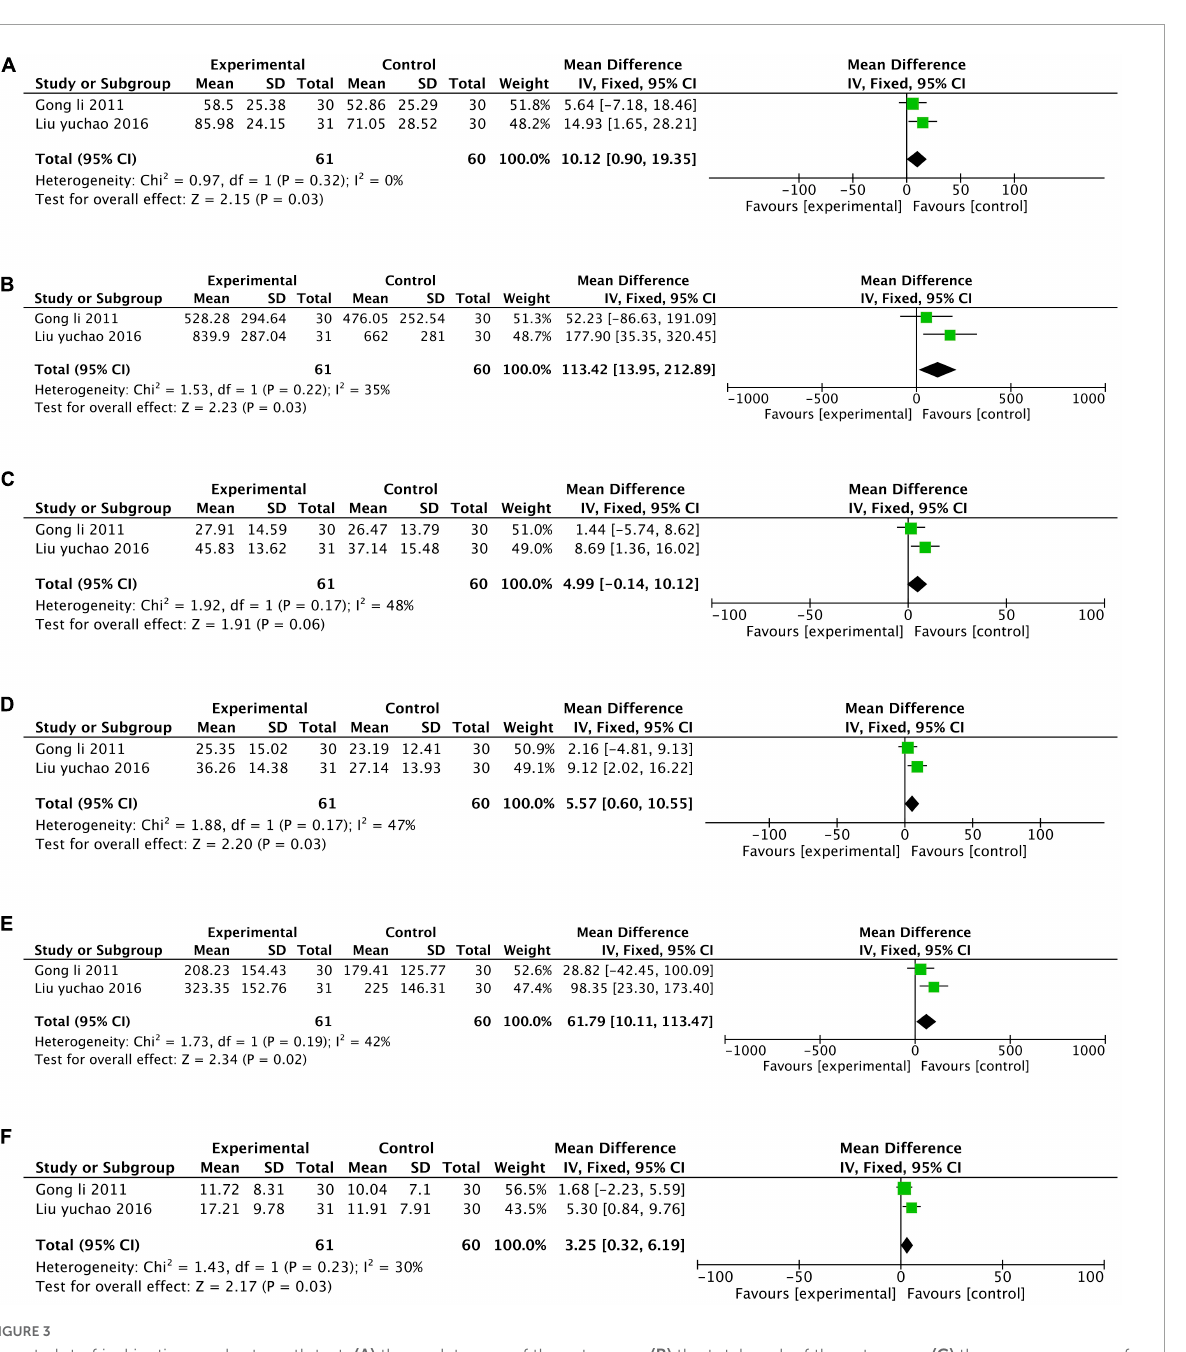
FIGURE3 Forest plot of isokinetic muscle strength test: (A) the peak torque of the extensors; (B) the total work of the extensors; (C) the average power of the extensors; (D) the peak torque of the flexors; (E) the total work of the flexors; (F) the average power of the